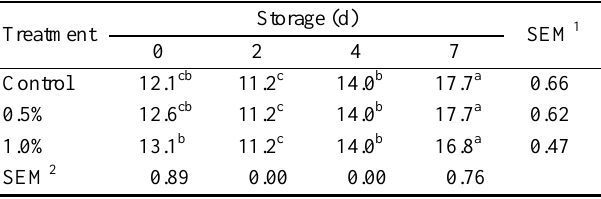
Table 4. Volatile basic nitrogen (mg %) in the thigh meat from the broilers fed combination of gallic and linoleic acid Storage Treatment